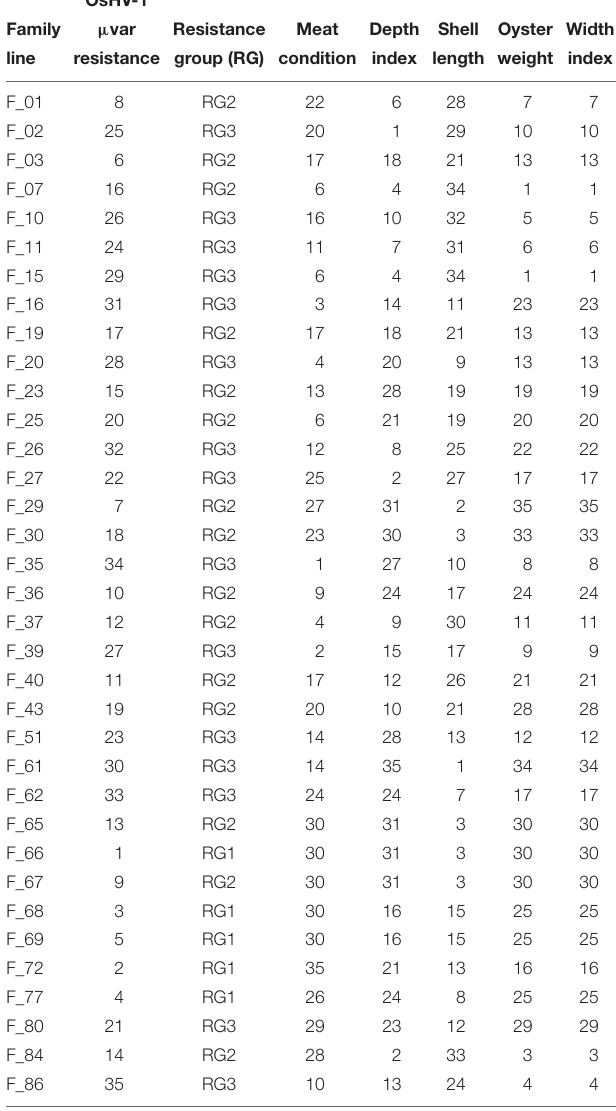
TABLE 1 | Expected breeding value ranks for the studied oyster families including OsHV-1 µ var disease-resistance. OsHV-1 Family µ var Resistance